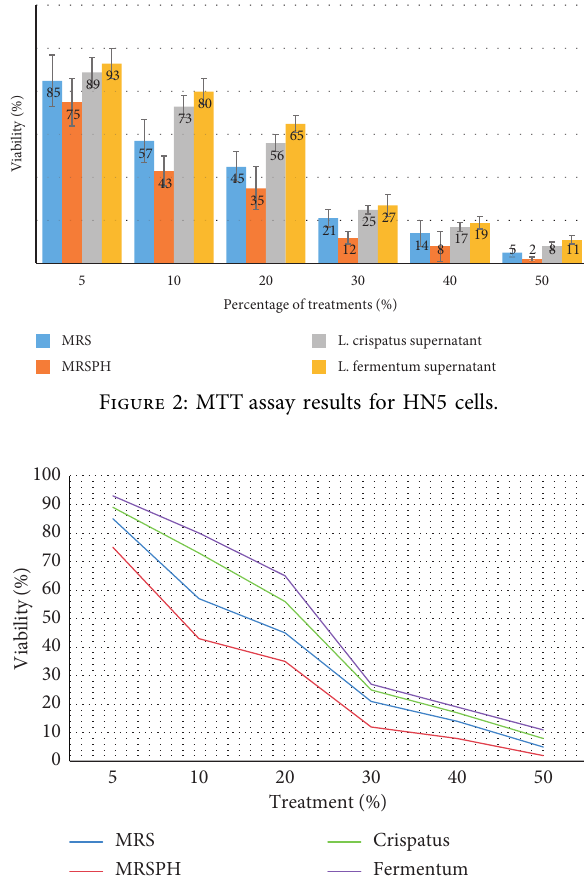
Figure 3: Linear curve of the growth inhibition rate of cancer cells in 4 different